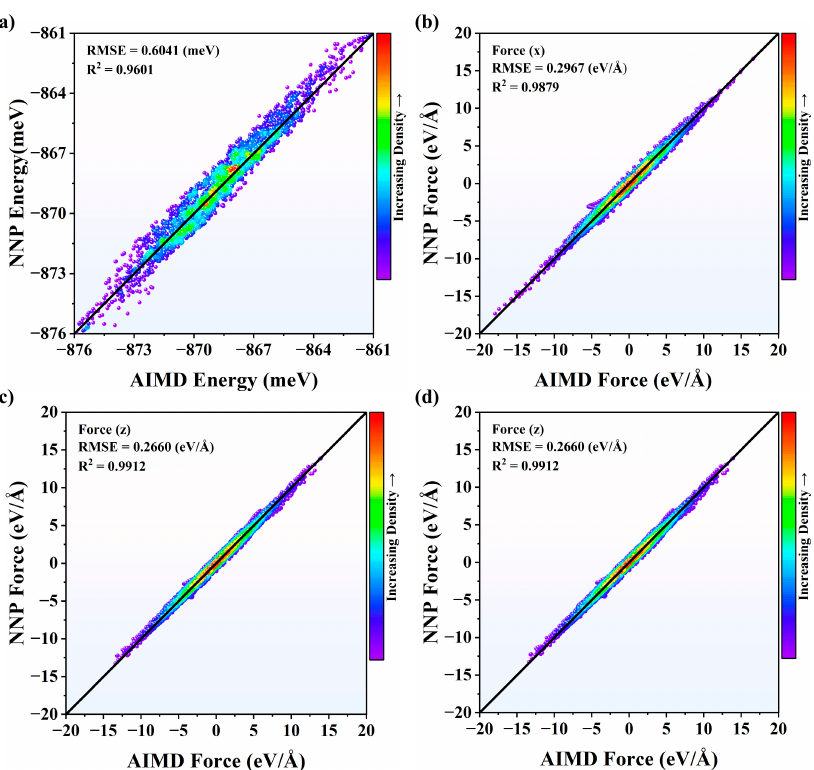
Figure 1. The comparisons of ( a ) energies and ( b – d ) forces from NNP and AIMD for Si 3 N 4 at 2000 K in x , y , and z directions.